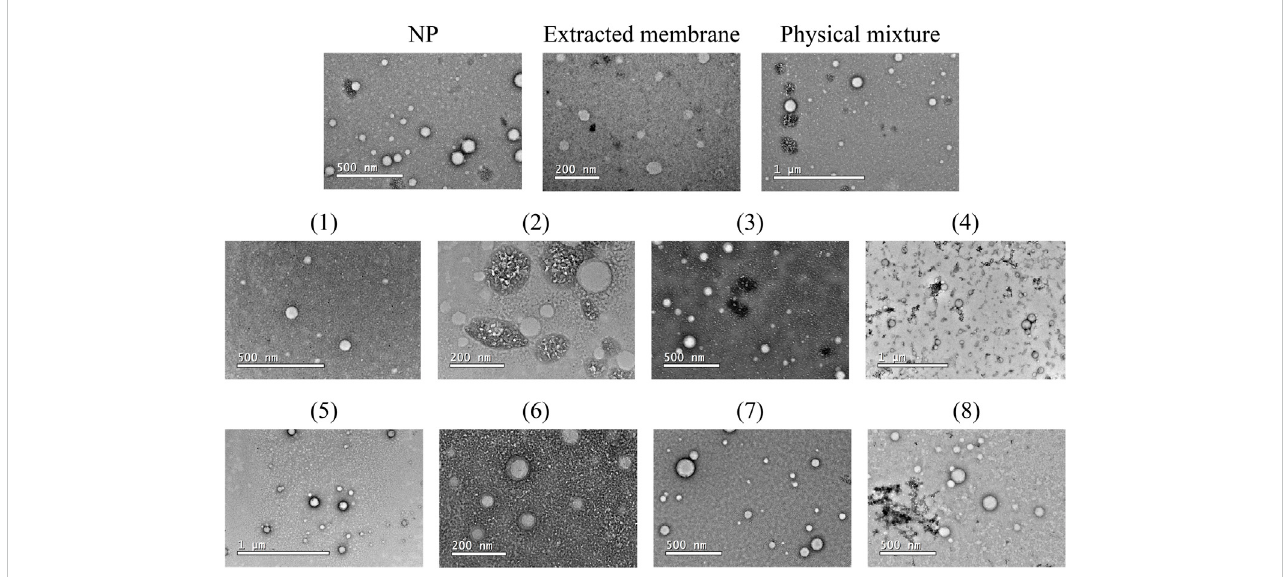
FIGURE 4 Morphologicalanalysis ofexperimentalconditionsgeneratedbyDoE.Representativeimages ofNP,MB(extractedmembrane)asanegativecontrol,and 8runconditionsbynegative-stainingTEM.Imageswererecordedusingnegative-stainingtransmissionelectronmicroscopy(TEM)JEM-2100-JEOL200with a LaB6 source operating at an acceleration voltage of 200